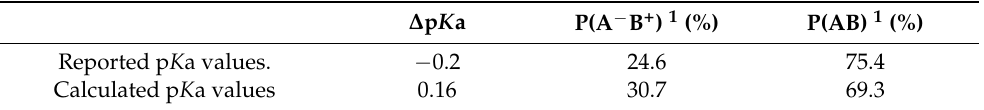
Table 5. Calculated probability for salt or co-crystal formation for the protonation of benzimidazole nitrogen with the second maleic acid molecule in the glasdegib–maleic acid 1:2 complex. ∆ p K a Reported p K a